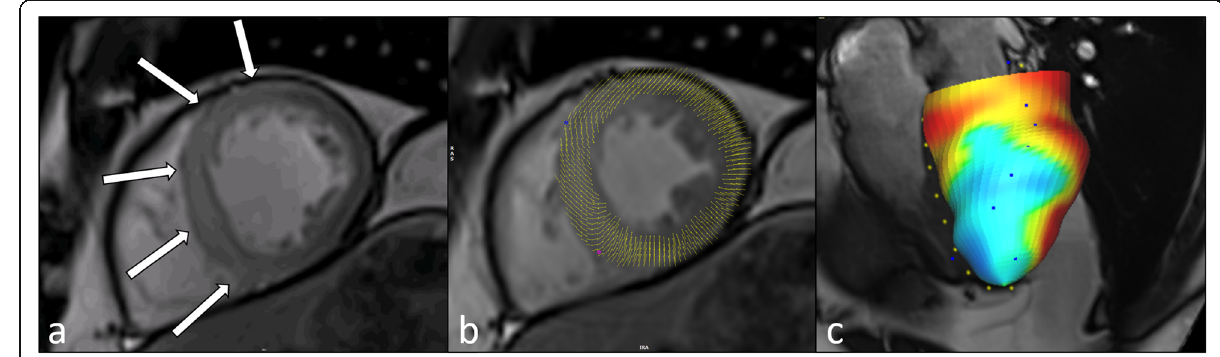
Fig. 1 Thirty-two-year-old man with acute anteroseptal myocardial infarction. Diastolic phase, post-contrast cine bSSFP image indicates areas of myocardial edema and wall motion abnormalities ( a , white arrows). Systolic phase image ( b ) is shown with myocardial displacement overlay. 3D visualization with Feature Tracking radial strain overlay indicates reduced contractility ( c , blue area) in the affected territory. bSSFP Balanced steady-state free